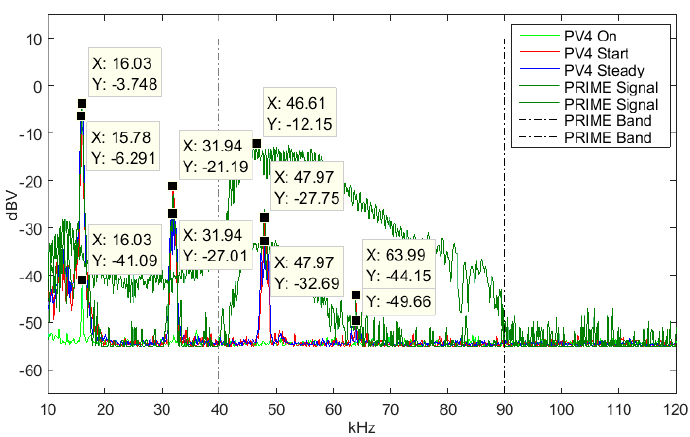
Figure 7. Spectrum recorded at the three-phased PV4 SM with the rest of devices disconnected.